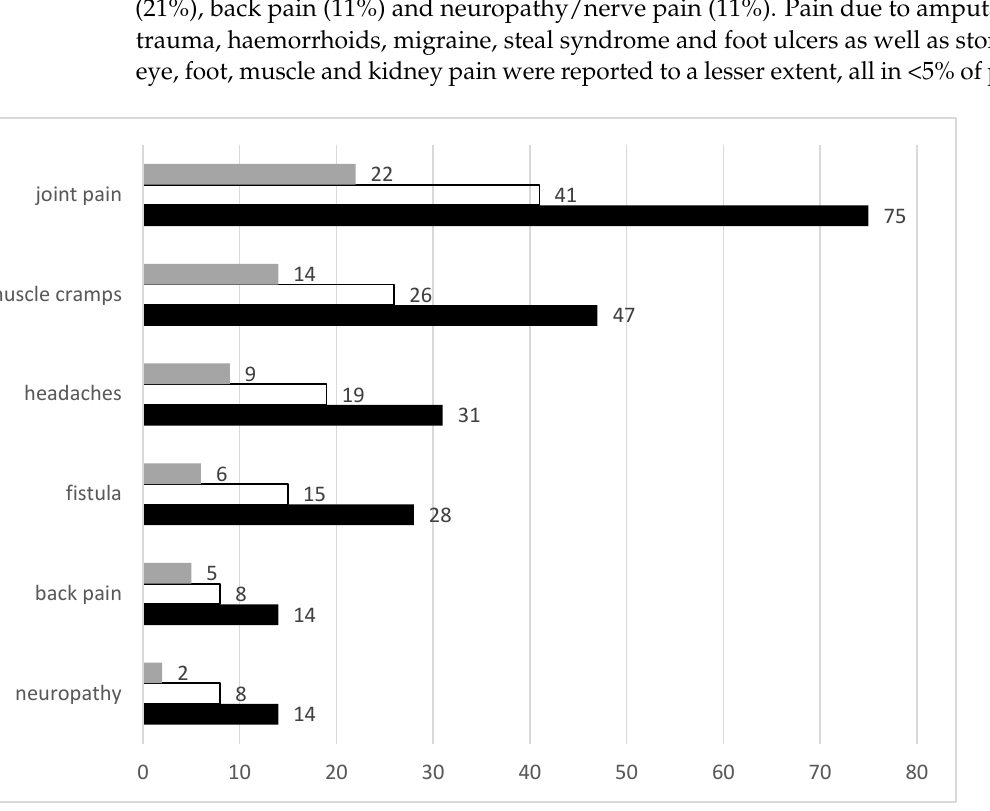
Figure 1. Most prevalent types of pain. The number of patients reporting pain is shown on the x axis. Multiple responses were possible. Not all patients nominated the severity of their pain. Black shading indicates total number reporting pain at that site; white represents slight to moderate pain intensity; grey represents severe to excruciating pain.